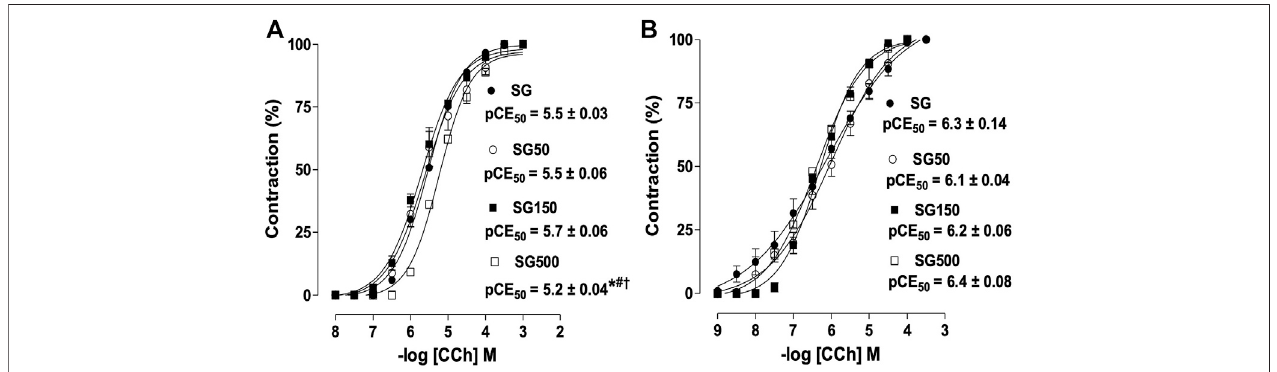
FIGURE 1 | Contractile effect of CCh in SG ( C ), SG50 ( ○ ), SG150 ( ■ ) and SG500 groups (.) in rat trachea in the presence (A) and absence of epithelium (B) . The symbolsand vertical bars represent themeanand S.E.M.,respectively(n=5). One-wayANOVA followed byBonferroni ’ spost-test. * p < 0.05 (SG vs. SG500), # p < 0.05 (SG50 vs. SG500) and † p < 0.05 (SG150 vs. SG500). CCh = carbachol. Healthy saline group = SG. Healthy group supplemented with S. platensis at 50, 150 and 500 mg/kg = SG50, SG150 and SG500, respectively.